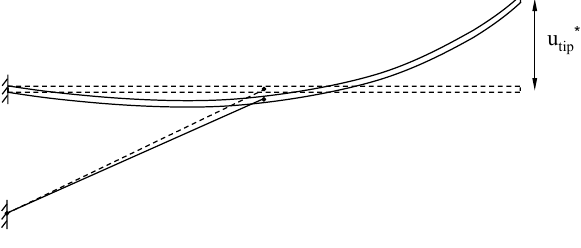
Figure 16. Invalid design with negative deflection near the